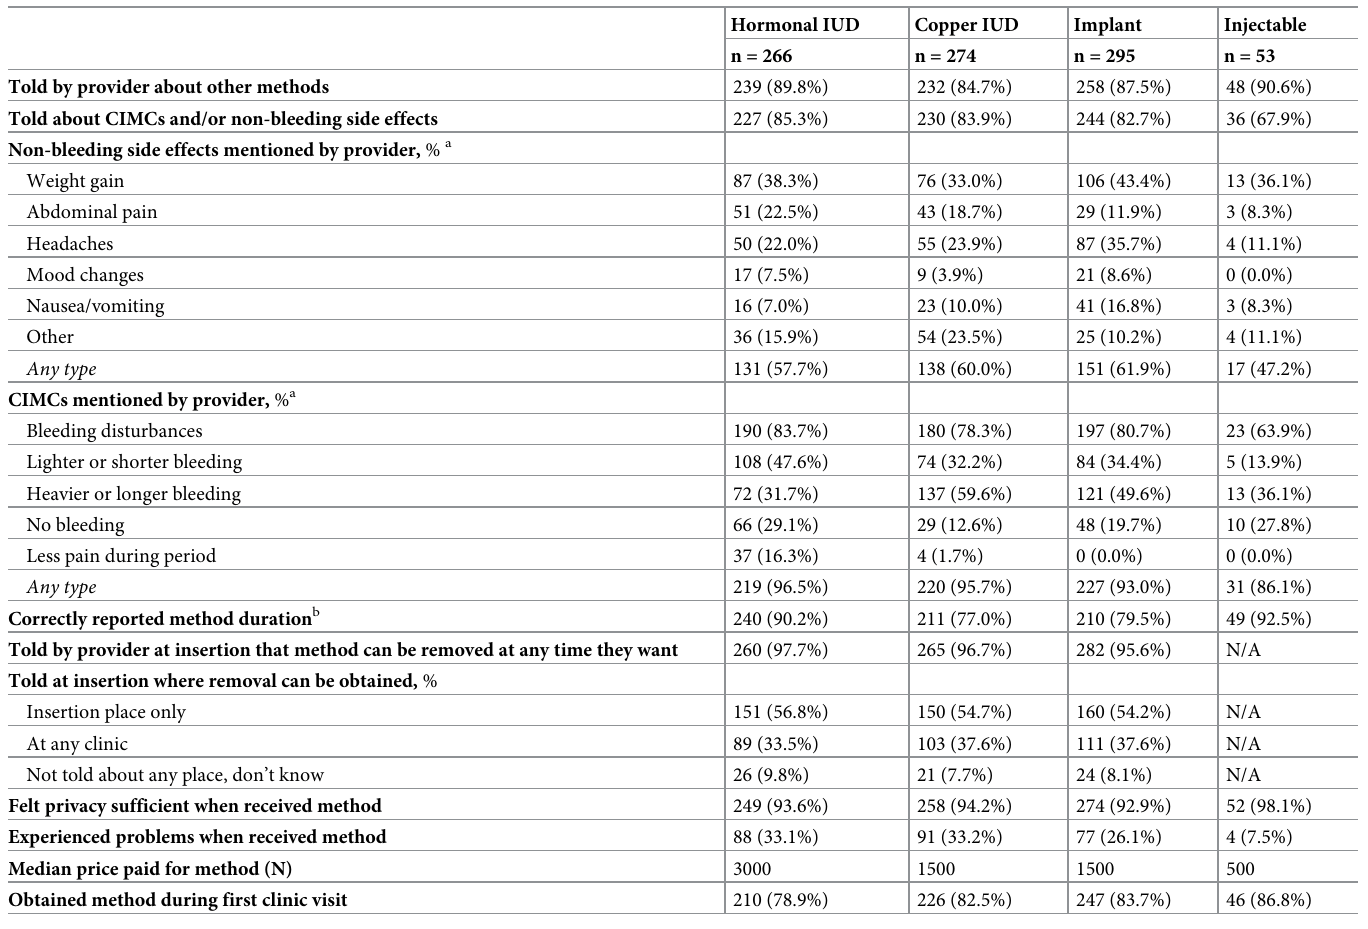
Table 4. Experience with counseling and